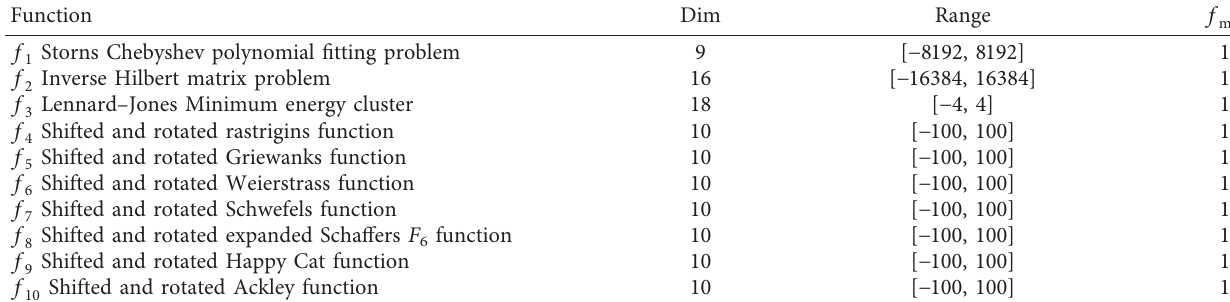
Table 8: The 100-digit challenge test function.